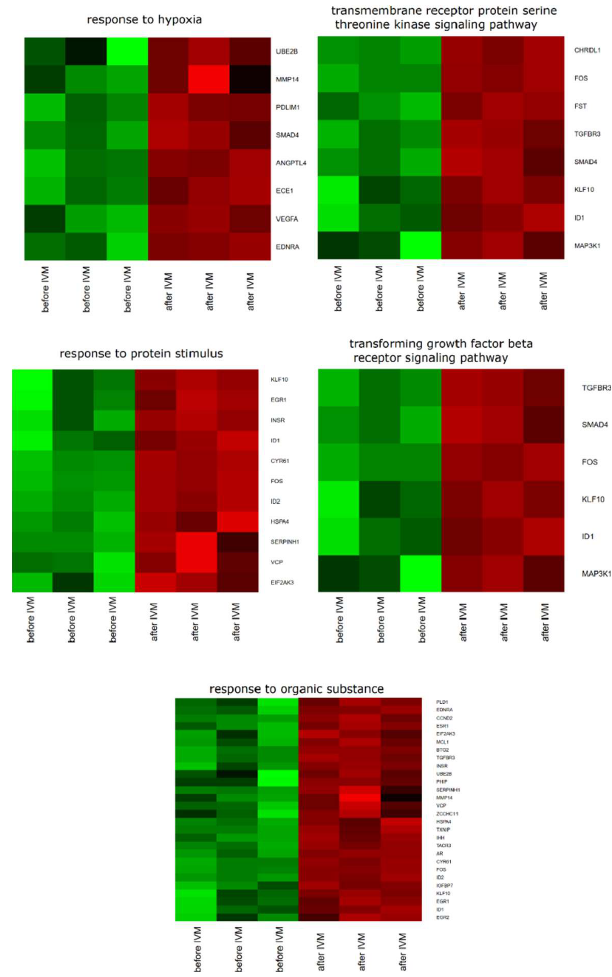
Figure 1. Heat map representations of differentially expressed genes belonging to response to hypoxia, “response to organic substance”, “response to protein stimulus”, the “transforming growth factor β receptor signaling pathway”, and “transmembrane receptor protein serine threonine kinase signaling pathway” gene ontology biological process (GO BP) terms. Arbitrary signal intensity acquired from microarray analysis is represented by colors (green, higher; red, lower expression). Log2 signal intensity values for any single gene were resized to Row z-Score scale (from −2, the lowest expression, to +2, the highest expression for a single gene).